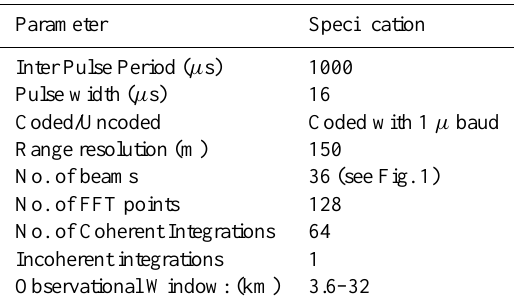
Table 1. Experiment Specification File (ESF) used for the MST radar